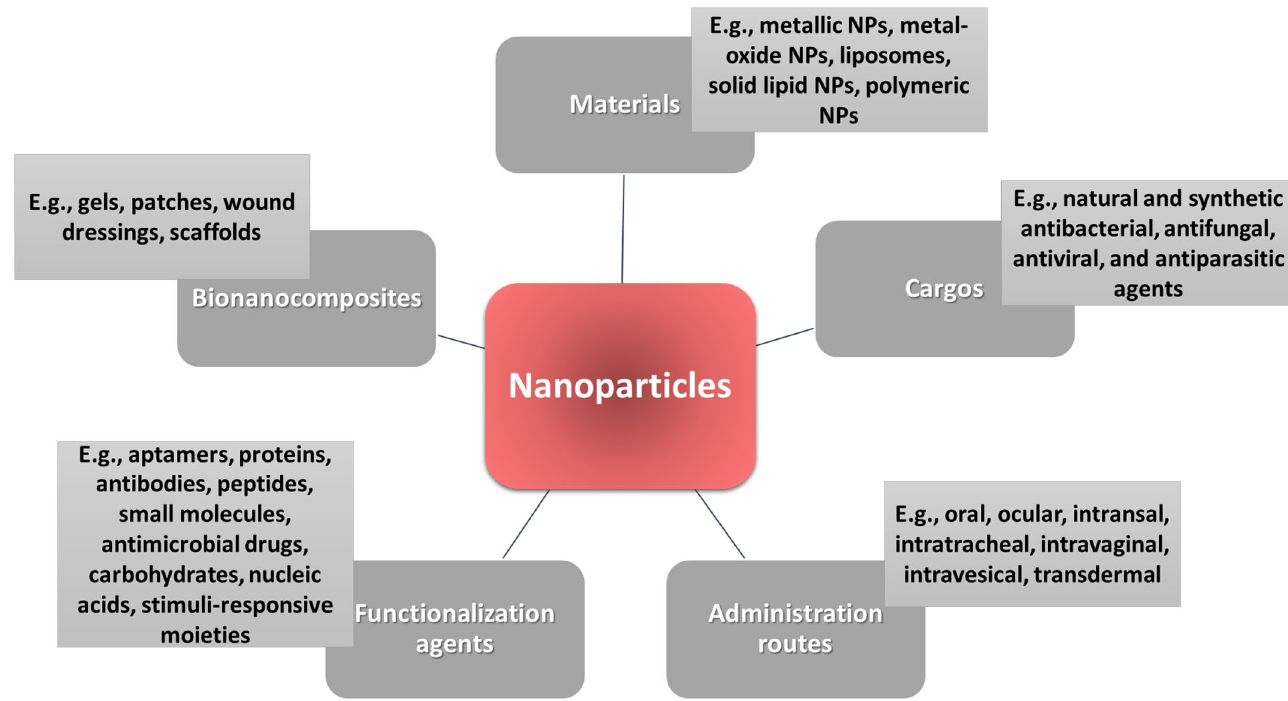
Figure 10. Overview of the possibilities of using NPs as delivery vehicles for antimicrobial applica ‐ tions.